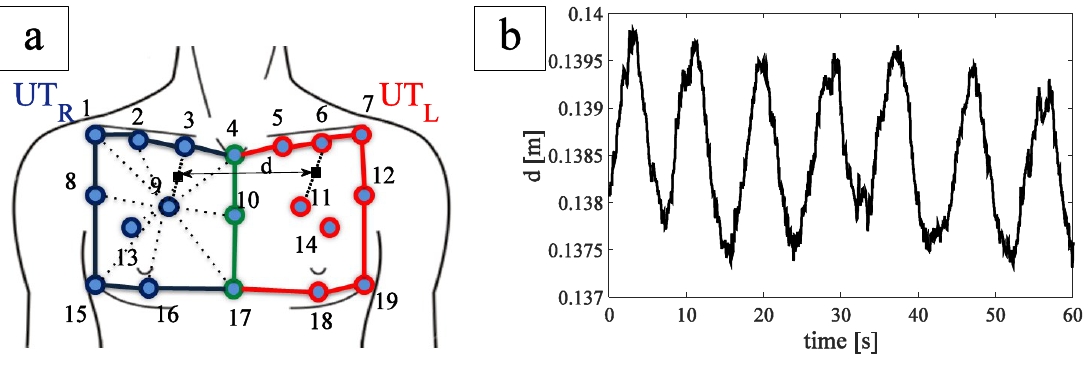
Figure 1. ( a ) FBGs position and distance between the two FBGs. Blue lines and markers identify the upper thorax right compartment, red lines and markers identify the upper thorax left compartment, green lines and markers identify the line which separates the two compartments; ( b ) trend of FBG distance during quiet breathing of a healthy